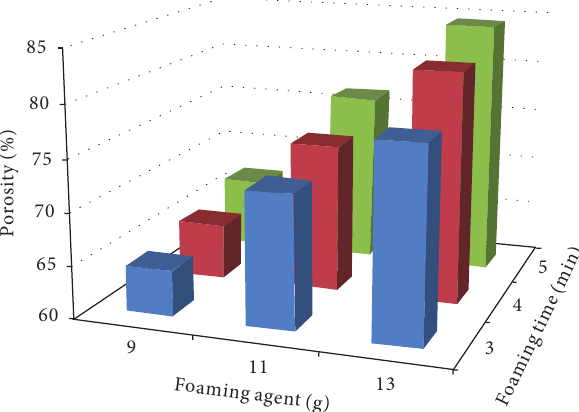
Figure 3: Effects of different foaming agents and microwave foaming time on the porosity of buffer